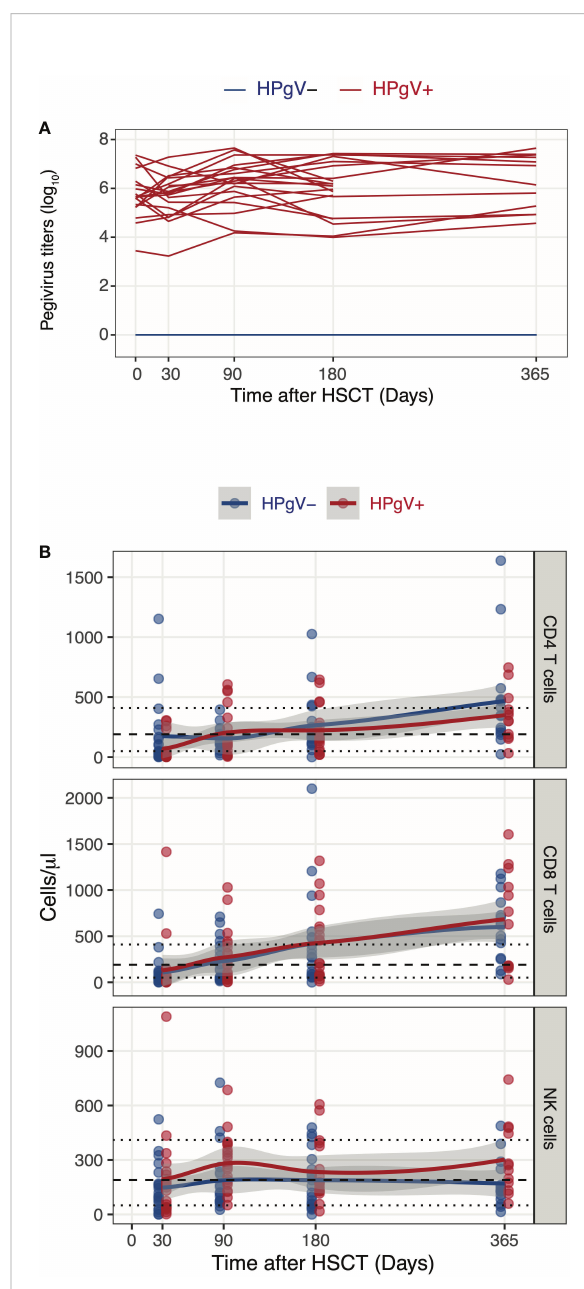
FIGURE 1 In fl uence of HPgV-1 replication on immune-reconstitution of mayor lymphocyte subsets after allogeneic HSCT. (A) Human Pegivirus-1 titer evolution through one year post-transplantation. Each line represents HPgV-1 titers in log10/RNA copies per ml of plasma in single HSCT recipient. Line colors indicate the patient ’ group (red lines: HPgV-1-viremic patients; blue lines: HPgV-1- non viremic patients). Lower limit of quanti fi cation (LLOQ) = 2.6E3 copies/mL. (B) Absolute CD4 T cell, CD8 T cell and NK cell numbers through one year post-transplantation strati fi ed by patients ’ group. Each dot represents one sample, lines represent Loess fi t lines and the grey area represents the 95% con fi dence interval (CI) for the regression fi